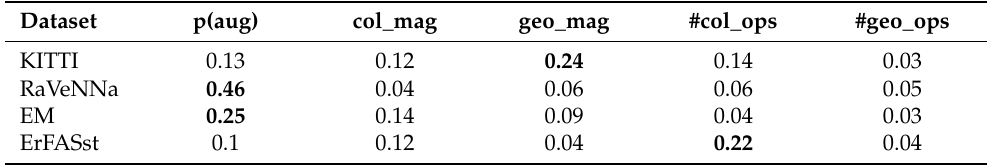
Table 5. Hyperparameter importance study for different hyperparameters across different datasets on SmartAugment experiments. For instance, for the RaVeNNa dataset, the probability of applying a data augmentation strategy is responsible for 46% of mean IoU’s variability across the configuration space. The higher the importance value, the more potential it has to improve the performance for a given dataset.